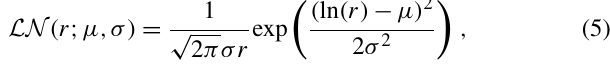
Table 1. Fit parameters according to Eq. (1)–(4), standard errors ( ± ), and AIC and RMSE values for the regression types and parameter σ of the log-normal distributions ( LN , Eq. 5) fitted to the residuals, for the data from Canada (Delcan Corporation, 2012) and the Netherlands (de Grave and Baase, 2011). The root-mean-squared error is calculated according to RMSE = values and Y i are the measured ones. For both AIC and RMSE, smaller values are